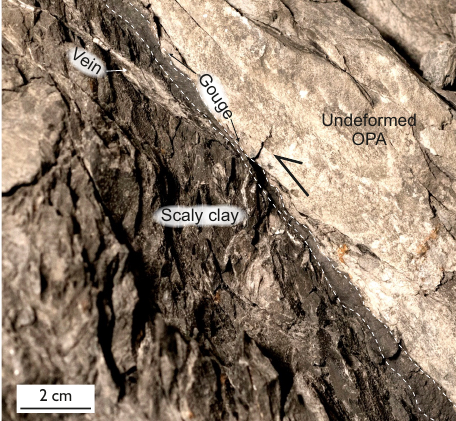
Figure 2. Outcrop picture of the continuous gouge band at the upper fault zone boundary in gallery 98 (view to